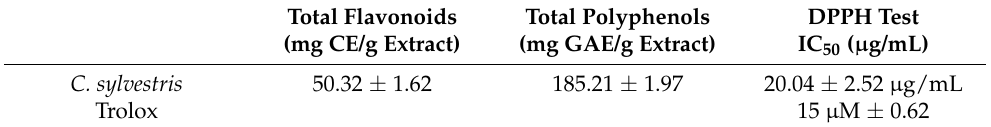
Table 1. Total polyphenols and flavonoids and DPPH-scavenging activity of Cynara sylvestris leaf extract.